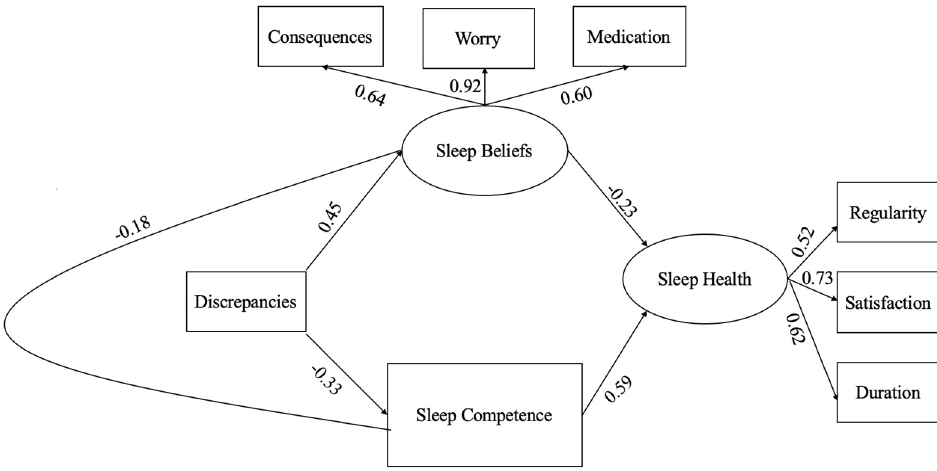
Figure 3. Final structural equation model with significant pathways presented.